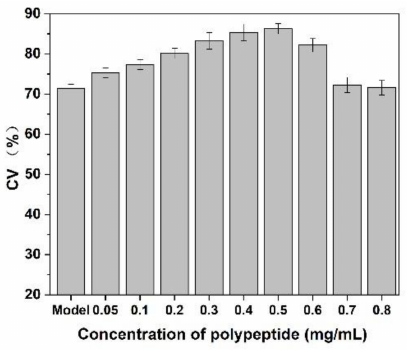
Figure 10. The effect of Cornus officinalis peptides on the oxidative damage CEF cells. Experimental conditions: phosphate buffer (pH 7.4), at 37 ◦